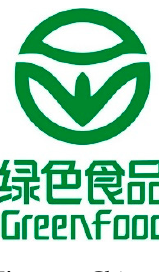
Figure 2. Chinese green food label